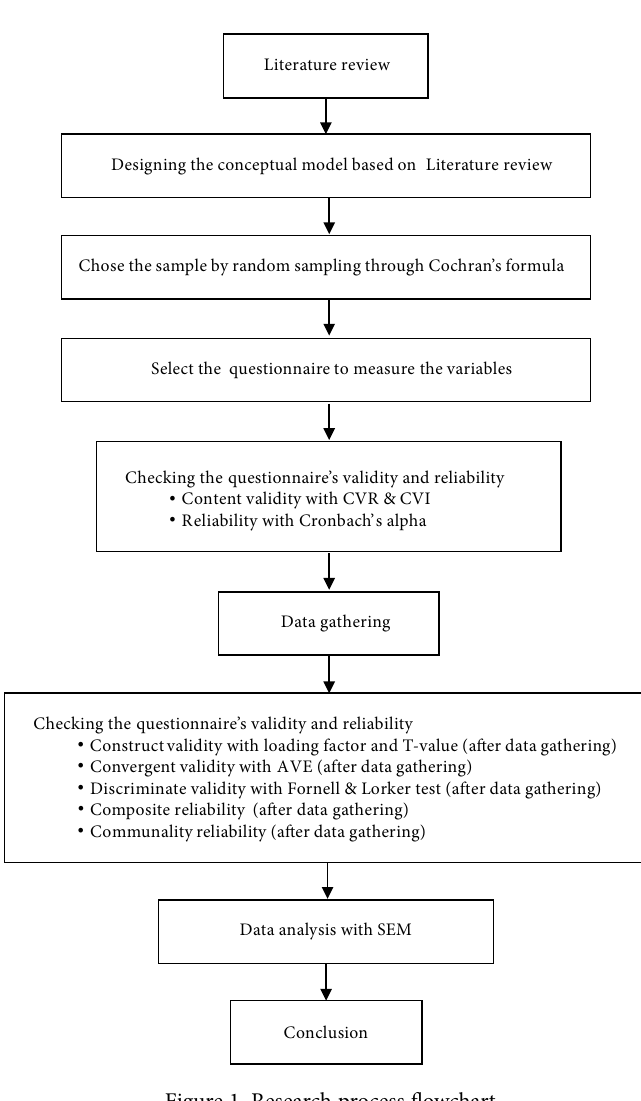
Figure 1. Research process